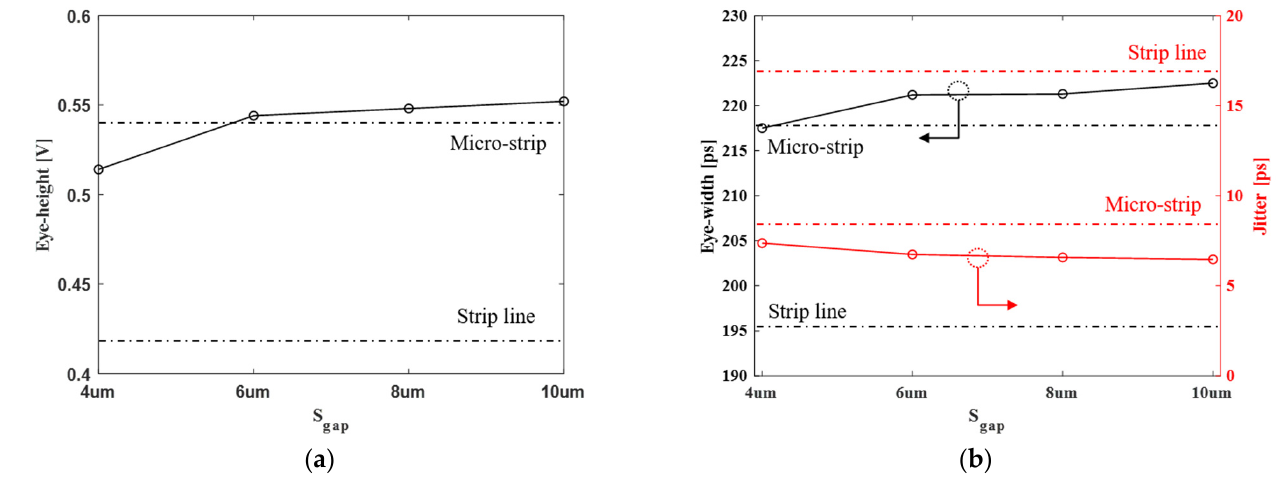
Figure 16. Summary of the eye-diagram data: ( a ) eye-height and ( b ) eye-width and jitter. Figure 16 indicates how much of a gap of the vertical channel needs to be selected to show a better eye margin than the conventional channel structure. The proposed channel structure shows better signaling performance than the micro-strip line when the vertical channel gap is more than 6 µ